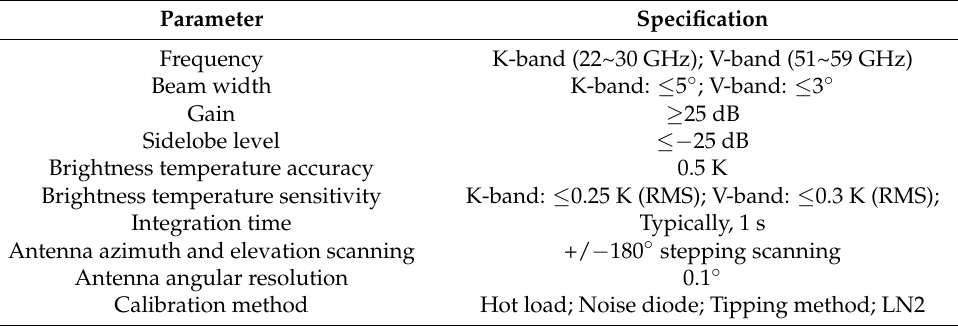
Figure 2. The multichannel microwave radiometer used for this experiment. Table 1. The system performance of the GMR used in this study.